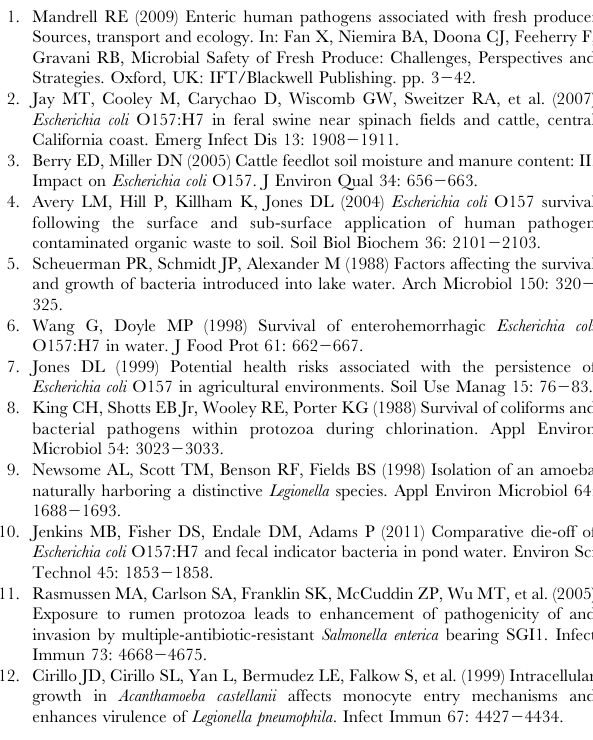
Table S1 MLVA characteristics of EcO157 strains used. Number of tandem repeats at each of 11 loci are given. Table S2 Two-way ANOVA comparisons of strain differences in fitness of EcO157 to protozoan predation, protozoan growth response to EcO157 consumption and influence of protozoan exposure on proportion of curli